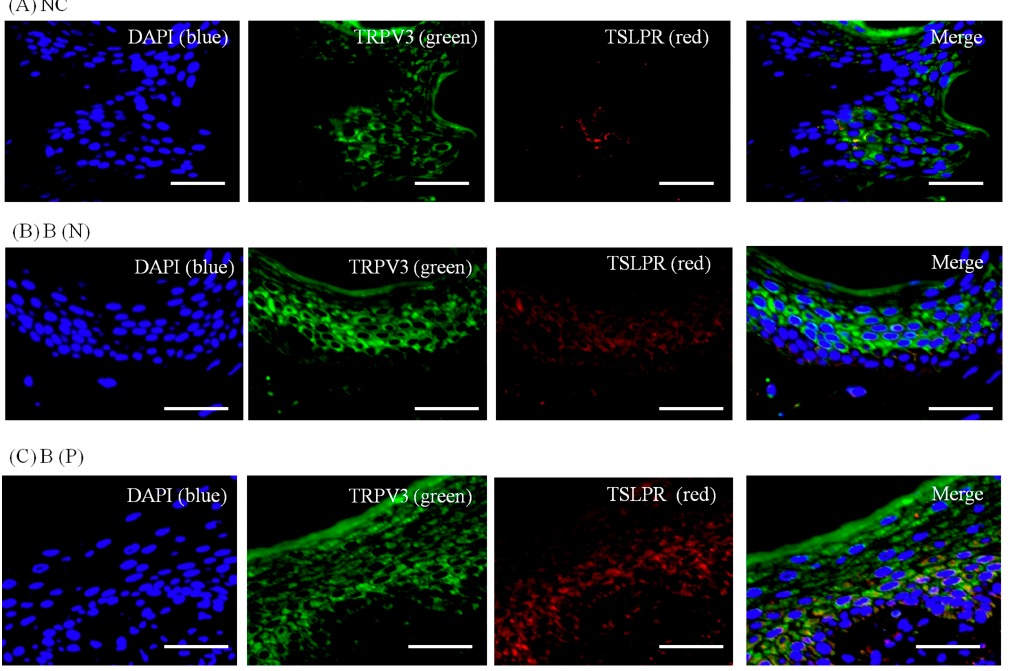
Figure 10. Three-color immunofluorescence confocal images were obtained for DAPI ( blue ), TRPV3 ( green ) and TSLPR ( red ) from skin tissues of ( A ) normal, ( B ) nonpruritic and ( C ) pruritic burn scars. The staining of TRPV3, well observed in spinous layer of the epidermis, and TSLPR, in lower spinous and basal layer, was least in ( A ) normal control and higher in ( B , C ) burn-scar tissues with or without pruritus. Staining of TSLPR was greatest in burn-scar tissue with pruritus. NC: keratinocytes from normal control; B (N): keratinocytes from nonpruritic burn scar; B (P): keratinocytes from pruritic burn scar; TSLPR: thymic stromal lymphopoietin receptor. Scale bars = 50 μ m.